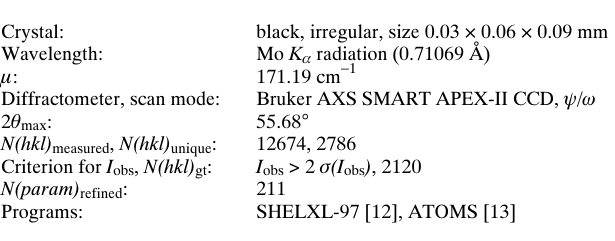
Table 1. Data collection and